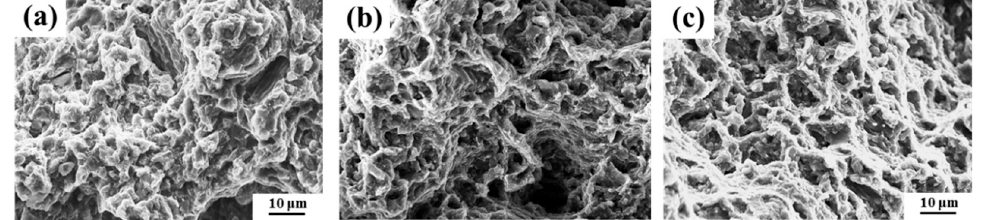
Figure 11. SEM micrograph of fracture at 150 °C: ( a ) Mg-4Al-4 (La, Ce); ( b ) Mg-4Al-4 (La, Ce)-1Sm; ( c ) Mg-4Al-4 (La, Ce)-2Sm.